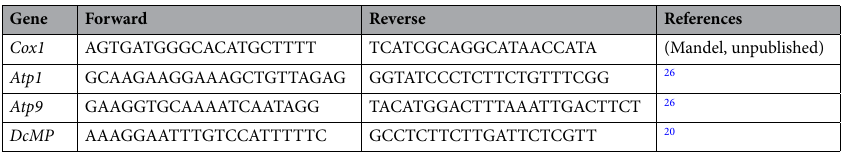
Table 6. Primer set used for molecular characterization of somatic